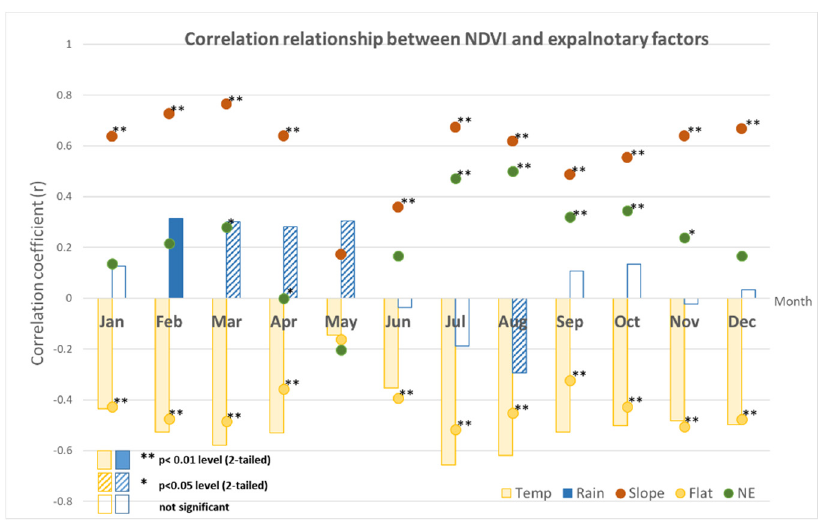
Figure A15. Results of Pearson’s correlation analysis for NDVI and explanatory factors of each month.